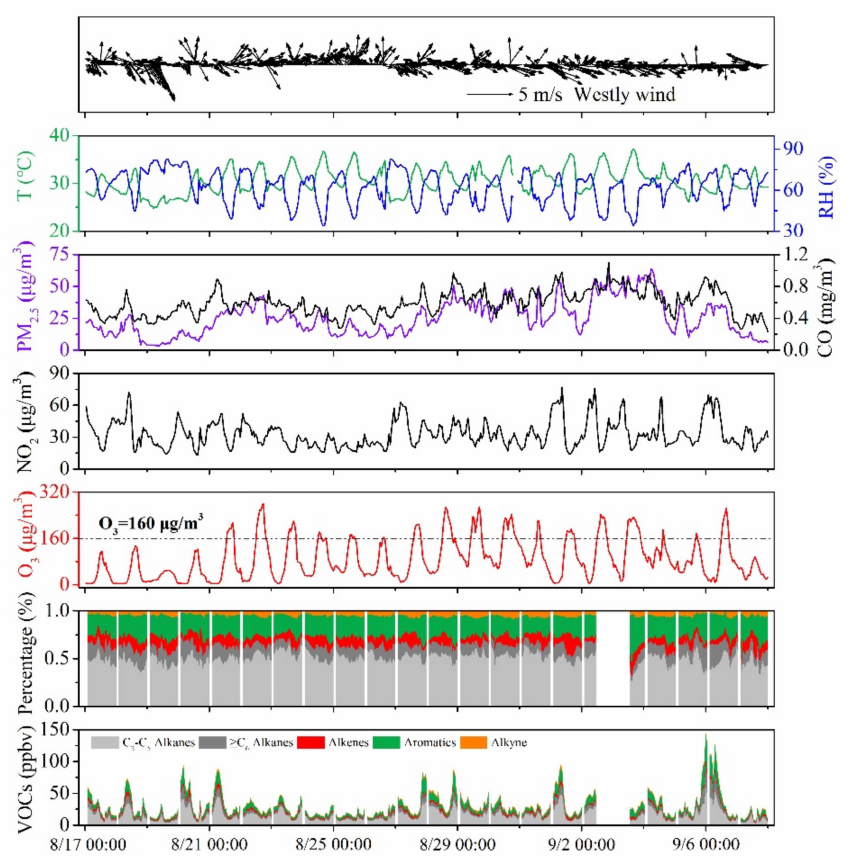
Figure 2. Time series of observed VOCs, O 3 , NO 2 , PM 2.5 , and meteorological parameters (tempera- ture, humidity, wind speed, wind direction) at PY site during the campaign. During the campaign, the mixing ratio of VOCs ranged from 6.59 to 144.38 ppbv, averaged as 31.80 ± 20.82 ppbv. C 2 –C 5 alkanes were the most abundant VOC species, with a mean concentration of 15.33 ± 9.66 ppbv, and amounted to 48.2% of the total measured VOCs during sampling (Figure 3). The respective levels of aromatics, ≥ C